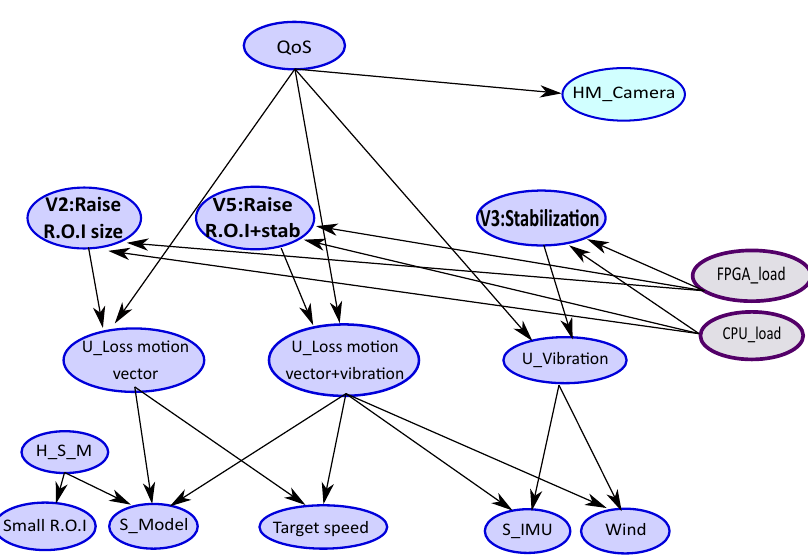
Figure 21. Resource-aware Health Management (HM).